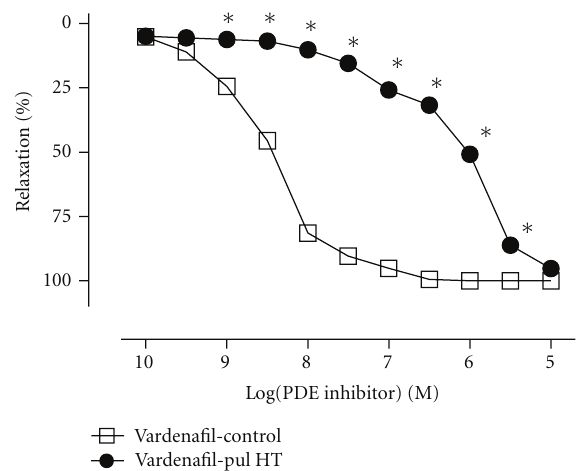
Figure 2: Concentration- response curves (10 − 10 –10 − 5 M; n = 15) to vardenafil in control and pulmonary hypertensive rat pulmonary artery rings contracted by phenylephrine (10 − 6 M). Experimental values were calculated relative to the maximal changes from the contraction produced by phenylephrine in each tissue, which was taken as 100%. ∗ P < 0 . 05 as compared with control.